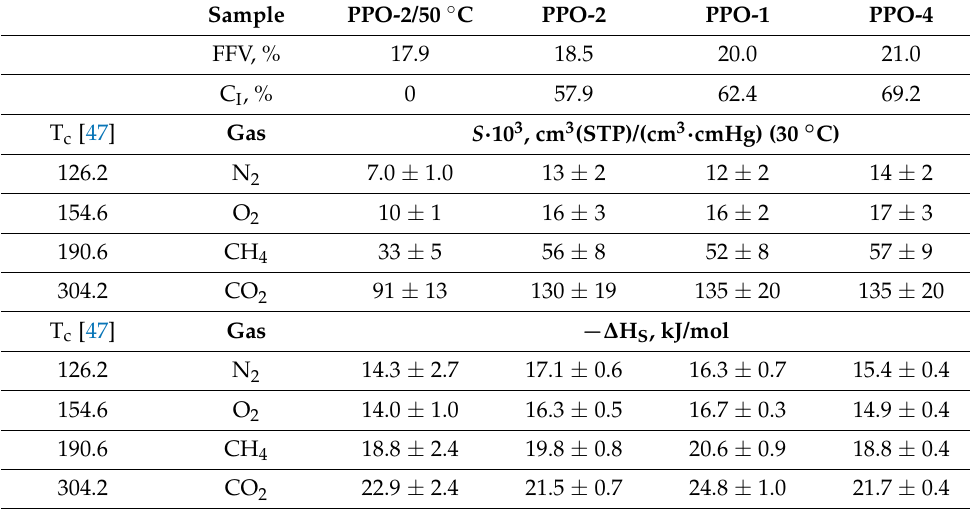
Table 7. Solubility coefficients ( S = P / D ) and heat of sorption values of gases for the studied PPO